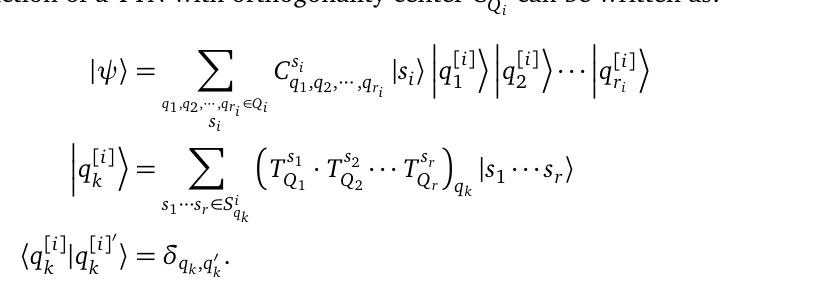
··· q . Each of these links corresponds 1 4 (cid:12) (cid:12) (cid:182) (cid:182) [ 4 ] [ 4 ] ··· (cid:12) (cid:12) q q . This orthogonality (cid:12) (cid:12) 4 1